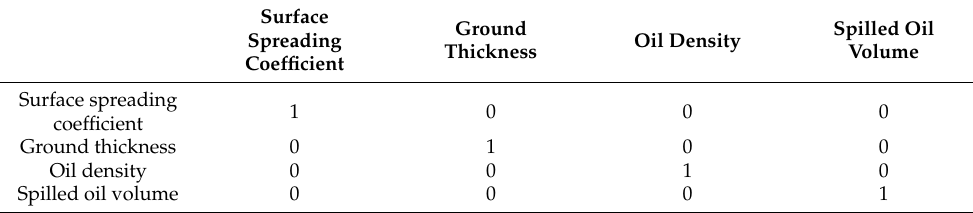
Spilled Oil Volume